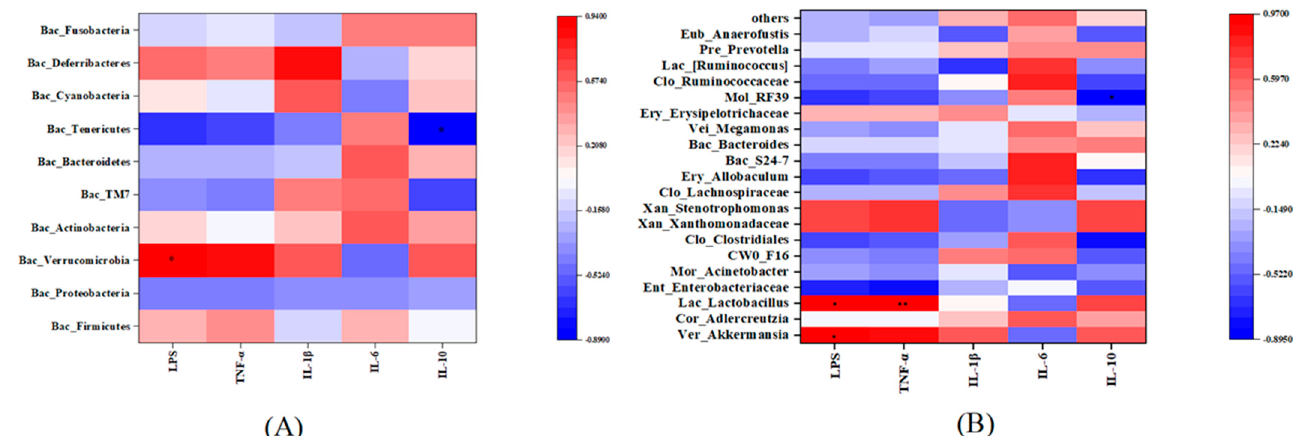
Figure 5. Heatmap of correlations between inflammatory factors and gut microbiota. ( A ): Correlation between inflammatory factors and gut microbiota at the phylum level. ( B ): Correlation between inflammatory factors and gut microbiota at the genus level. The color of the block represents the correlation between inflammatory factors and bacteria. * represents a significant correlation ( p < 0.05); ** represents most significant correlation ( p < 0.01).